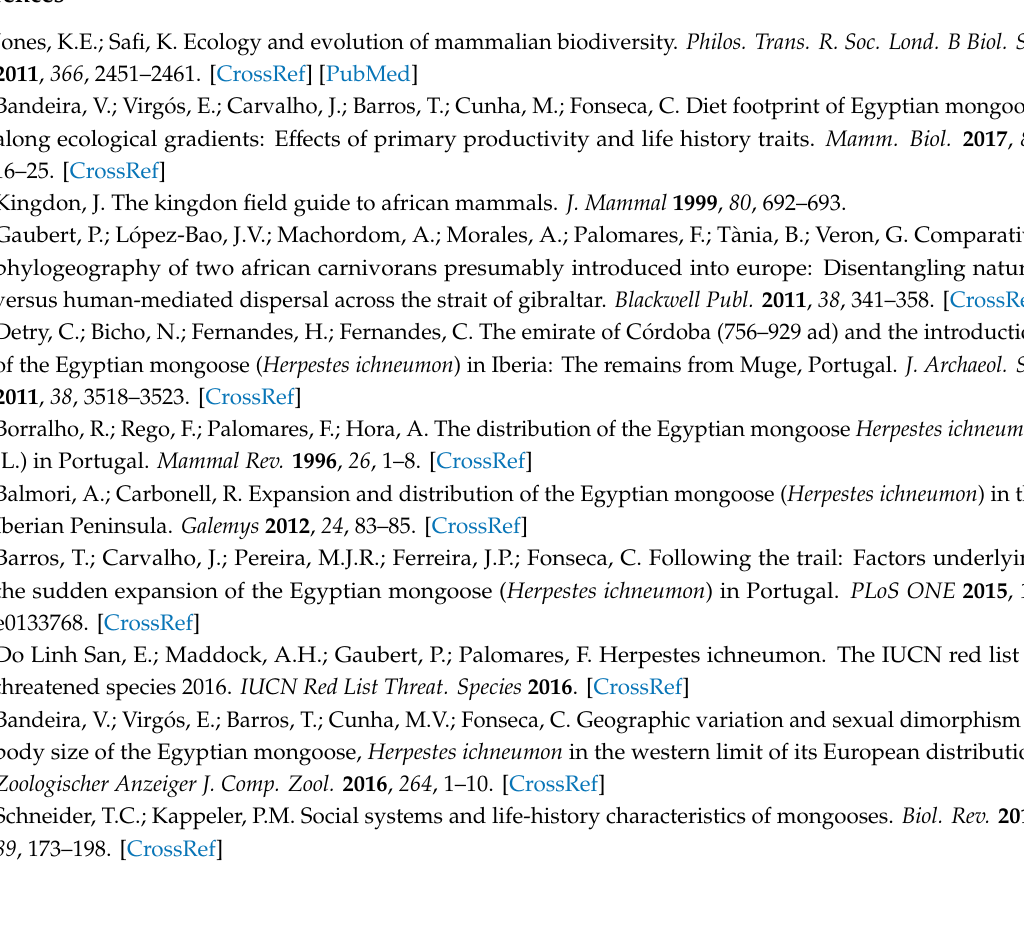
male and between non-adult and adult, Table S3: Taxonomic biomarkers discovery of female and male Egyptian mongoose fecal bacterial microbiota using a Kruskal-Wallis H test, Table S4: Taxonomic biomarkers discovery of non-adult and adult Egyptian mongoose fecal bacterial microbiota using a Kruskal-Wallis H test, Table S5: Functional biomarkers discovery of female and male Egyptian mongoose fecal bacterial microbiota applying a LEfSe analysis, Table S6: Functional biomarkers discovery of non-adult and adult Egyptian mongoose fecal bacterial microbiota applying a LEfSe analysis, Figure S1: Rarefaction curves for the twenty di ff erent fecal samples of Egyptian mongoose measured individuals using the observed species metric, Figure S2: Rank abundance curves for the twenty di ff erent fecal samples of Egyptian mongoose individuals using the observed species metric, Figure S3: Beta-diversity analysis to compare the fecal bacterial microbiota, on a genus level, of male and female Egyptian mongoose, Figure S4: Beta-diversity analysis to compare the fecal bacterial microbiota, on a genus level, of adult and non-adult Egyptian